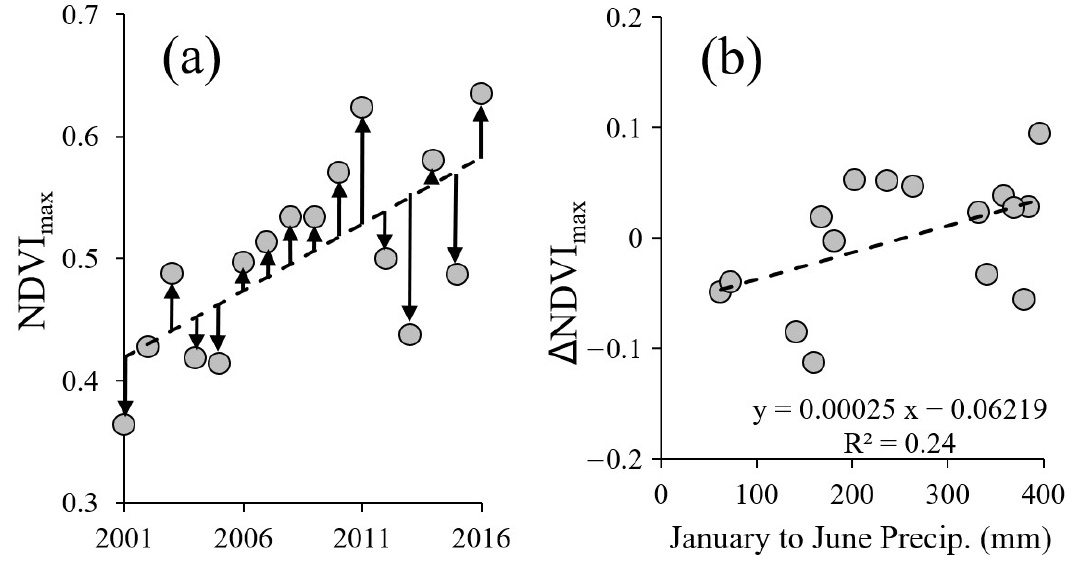
Figure 8. ( a ) Seasonal peak NDVI for summer for an average of all sample locations inside the irrigation district, and ( b ) the comparison between January–June precipitation and NDVI difference.